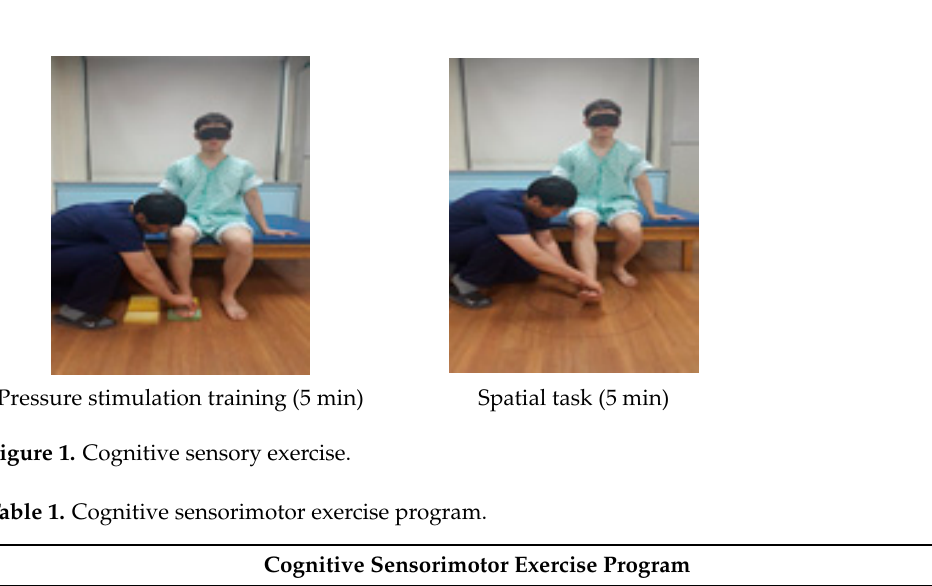
Table 1. Cognitive sensorimotor exercise program.